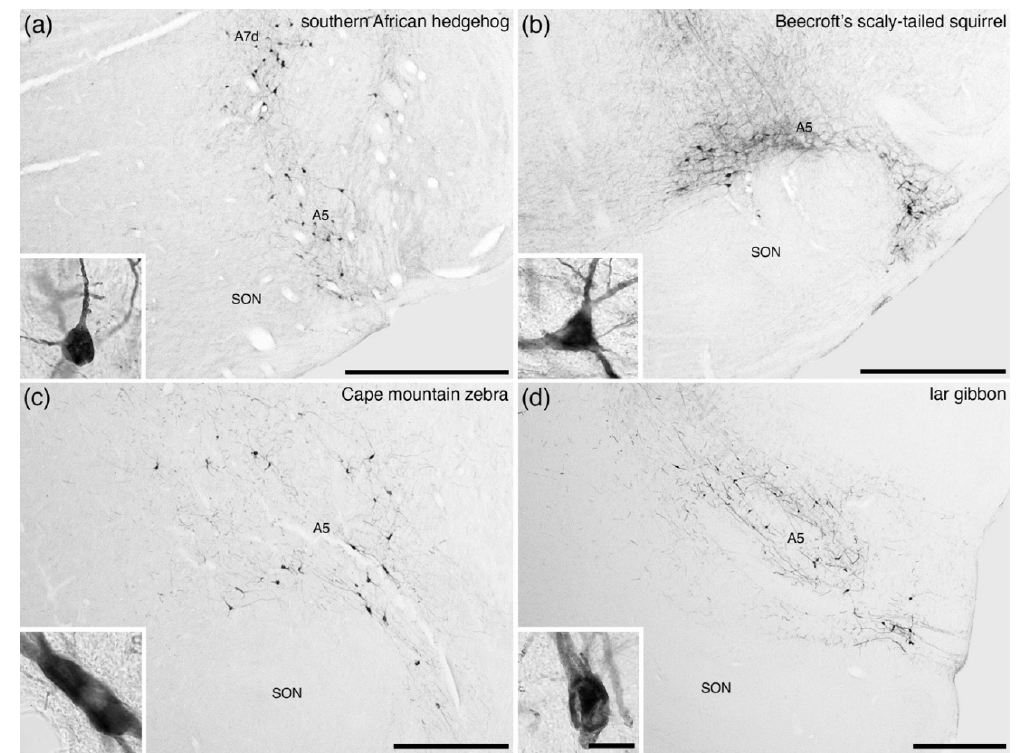
Figure 9. Low-magnification photomicrographs of the fifth arcuate, or A5 , nucleus, revealed with immunostaining for tyrosine hydroxylase, in ( a ) the southern African hedgehog ( Atelerix frontalis ) [19], ( b ) Beecroft’s scaly-tailed squirrel ( Anomalurus beecrofti ) [44], ( c ) the Cape mountain zebra ( Equus zebra zebra ) [pers. obs.], and ( d ) the lar gibbon ( Hylobates lar ) [58]. Note that across mammalian species this columnar nucleus appears to be invariably present and is consistently located in the same region of the brain, that being ventrolateral to the subcoeruleus, diffuse portion ( A7d ), and dorsolateral to the superior olivary nuclear complex ( SON ). Insets in each image show a high-magnification image of the neurons that form the A5 nucleus in each species. In all images, dorsal is to the top and medial to the left. Scale bars in ( a – d ) = 1 mm and apply to each specific image. Scale bar in inset ( d) = 25 µm and applies to all insets.